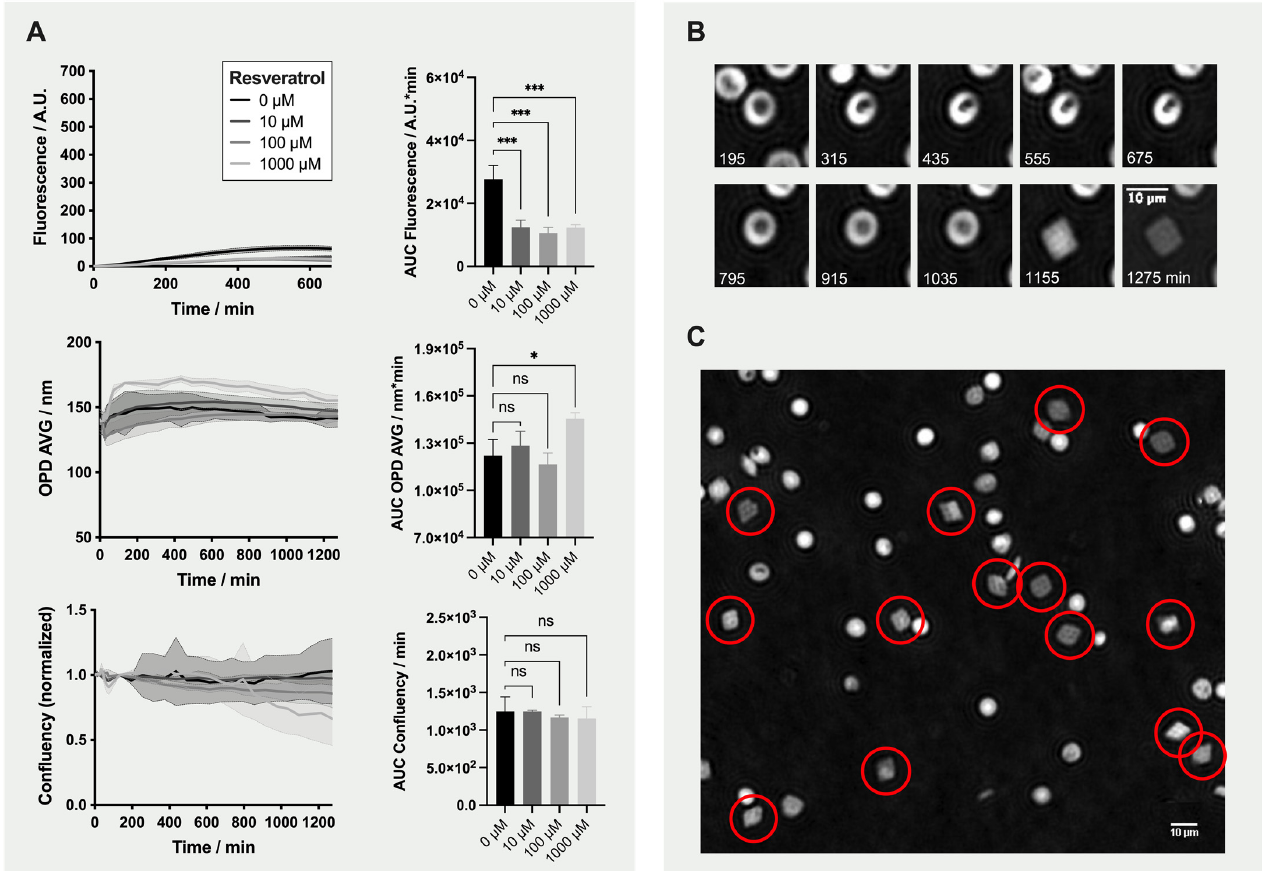
Figure 5. Effect of Resveratrol on Red Blood Cells (RBCs). Formation of “Tirocytes”. ( A ) Time-lapse analysis and the calculated AUC of fluorescence emission and morphology (i.e., average of the optical path difference distribution [OPD AVG] parameter and normalized confluency) for RBCs treated with 0, 10, 100 and 1000 µ M resveratrol only (no oxidants). * p -value < 0.05, *** p -value < 0.001, and “ns” non-significant. ( B ) Illustrative phase images showing the morphological changes leading to a diamond-shaped RBC (treated with 1000 µ M resveratrol). ( C ) Morphology of RBCs after 13h50 incubation with 1000 µ M resveratrol. Diamond-shaped “Tirocytes” are surrounded by a red